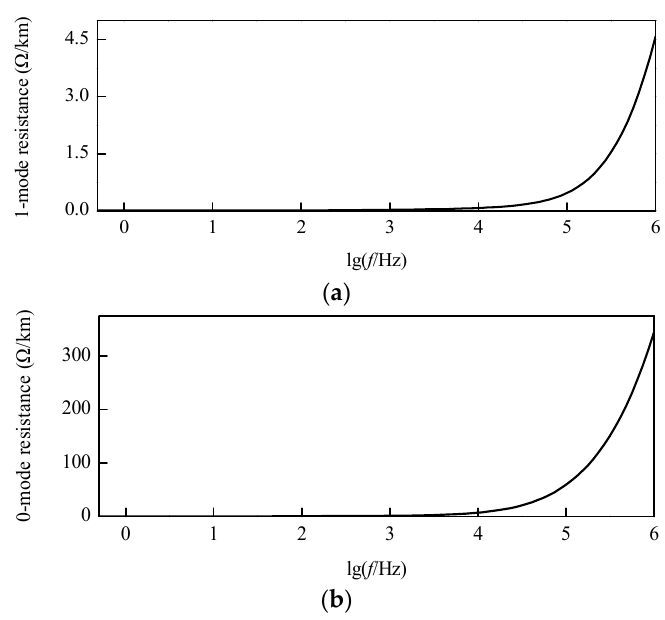
Figure 5. Modulus resistance characteristic curves: ( a ) 1-mode resistance; ( b ) 0-mode resistance. The modulus inductance characteristic curves after decoupling can be revealed by Figure 6.